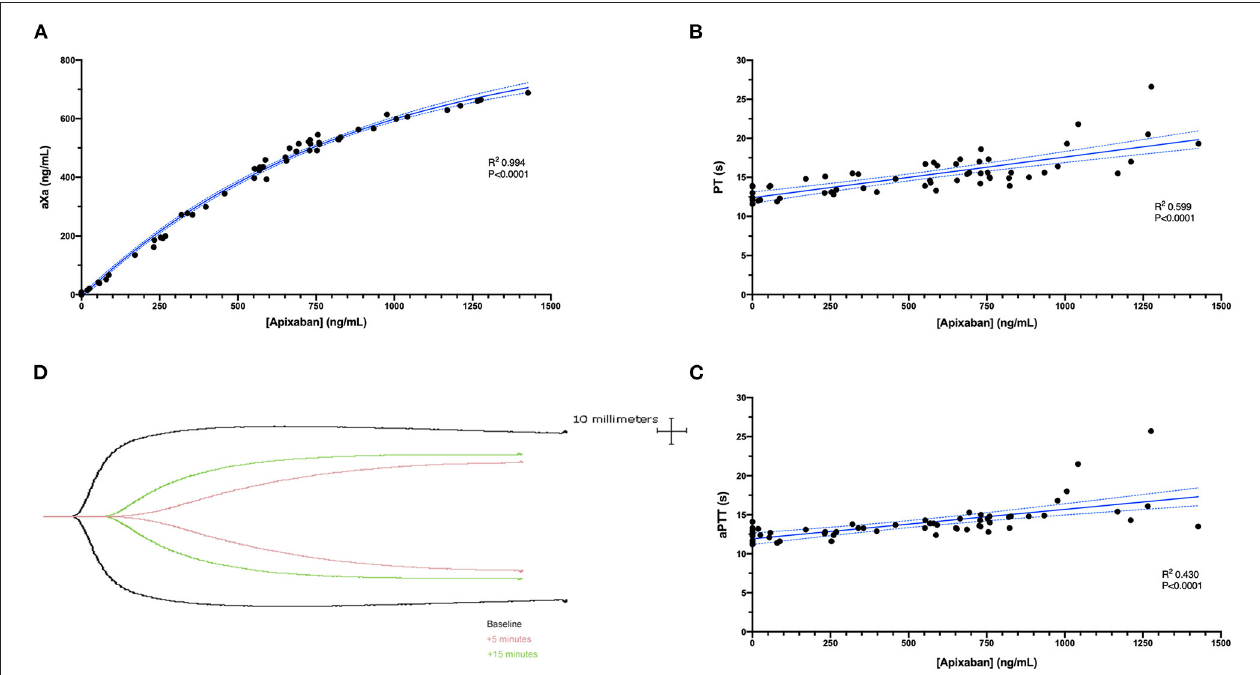
FIGURE 2 | ( A ) A scatterplot demonstrating the non-linear correlation between the plasma concentration of apixaban (abscissa) and the anti-Xa activity (aXa) (ordinate) following intravenous administration of apixaban (0.2 mg/kg). The correlation was highly positive (R 2 0.994, P < 0.0001). The solid blue line represents the non-linear regression line (exponential plateau), while the dotted blue lines represent the 95% confidence intervals of this line. ( B,C ) Scatterplots demonstrating the correlations between apixaban plasma concentrations (abscissa) and the prothrombin time (PT) or activated partial thromboplastin time (aPTT) (ordinate). These parameters were both positively correlated with the plasma apixaban concentrations (PT R 2 0.599, P < 0.0001; aPTT R 2 0.430, P < 0.0001). Solid blue lines represent the Pearson least-squares linear regression lines, while the dotted blue lines represent the corresponding 95% confidence intervals. ( D ) Representative TEG tracings (black, baseline; pink, 5min; green 15min) from a single dog following intravenous apixaban administration.